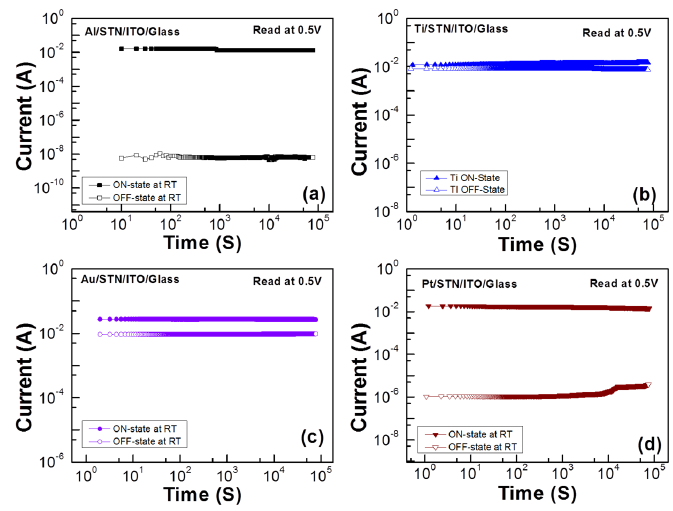
Figure 7. Retention test results of the RRAMs with the top electrode material of ( a ) Al; ( b ) Ti; ( c ) Au; and ( d ) Pt at room temperature (read at 0.5 V). Table 1. Comparison of metal/STN/ITO RRAMs with various top electrode metals. STN: Strontium titanate nickelate; ITO: Indium tin oxide; RRAM: Resistive random access memory; HRS: High ‐ resistance state; LRS: Low ‐ resistance state.